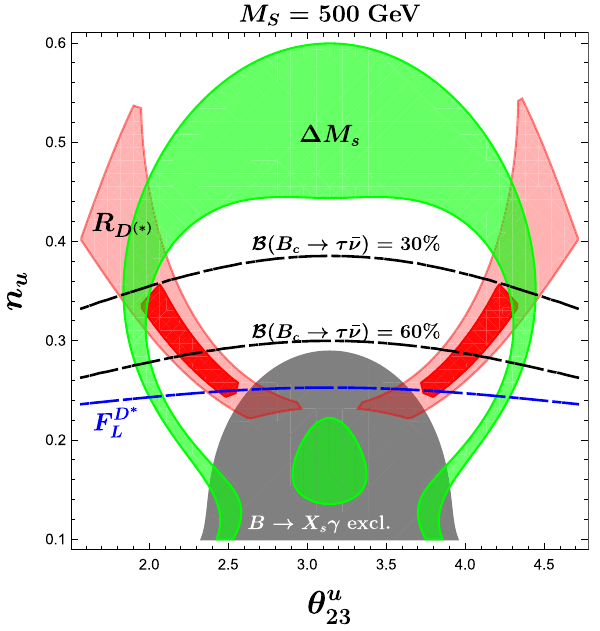
Fig. 3 NP effects on (cid:16) a μ under the constraints from LFV processes. The 1 − 3 σ regions of (cid:16) a μ [59] are shown in green. The region below the black, blue, and red curves are excluded by τ → 3 μ , μ → e γ = π is chosen to obtain a maximal NP and τ → μγ , respectively. θ u 33 (at 1 σ level). contribution to (cid:16) a L